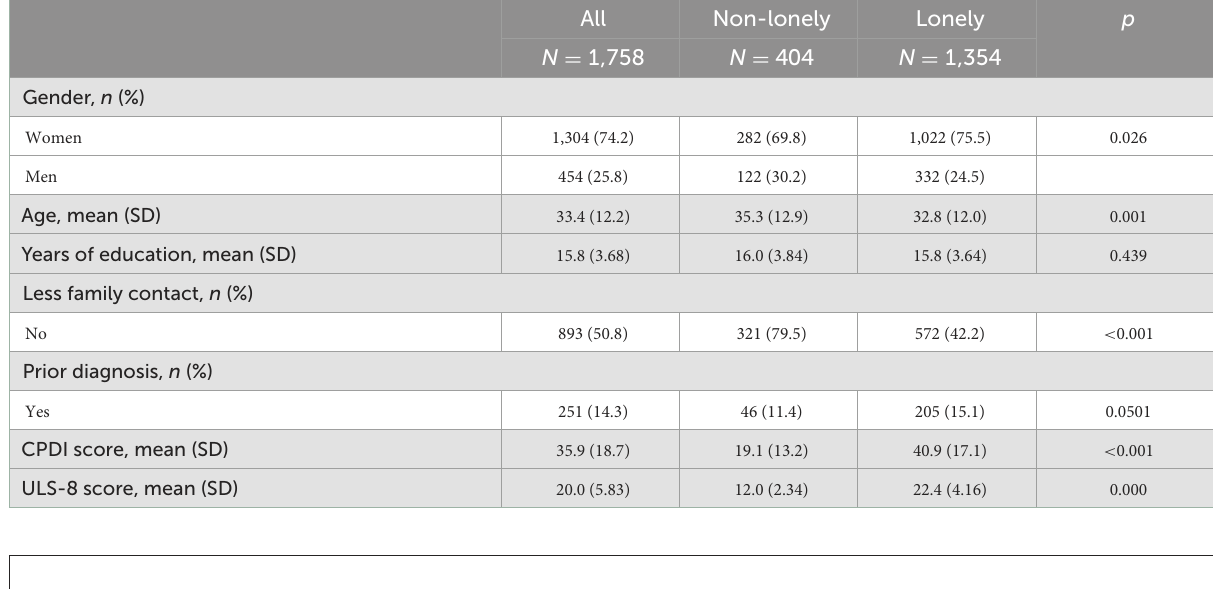
TABLE 1 Descriptive differences between non-lonely and lonely individuals.